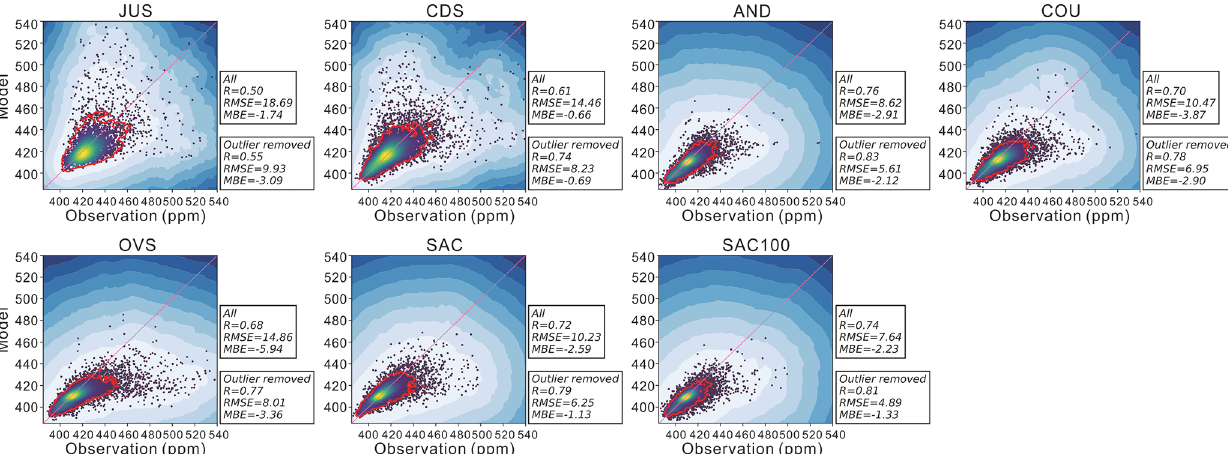
Figure 5. Observed and BEP_MYJ (control run) simulated all hourly CO 2 concentrations at six monitoring sites from December 2015 to November 2016. The color of dots represents the density of points at a given position. The shaded blue area indicates the anomaly score for each point, with the minimum in dark blue and the threshold value in light blue. The dots lying outside the red contour (threshold value) are the large model–data misfits (outliers) detected by the K -nearest neighbor (KNN) algorithm with an outlier fraction of 0.1.